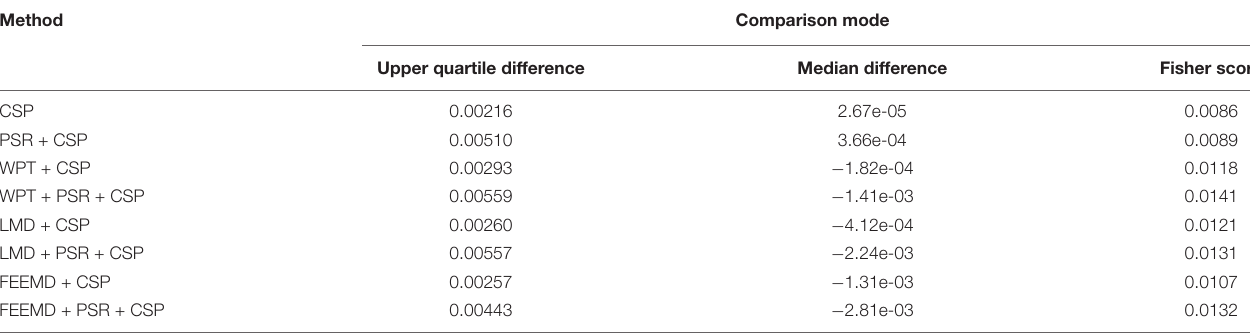
TABLE 4 | BPA values of test samples under the framework (cid:50) . S i and S i * represent the BPA of test samples 1 and 2, respectively. s f and s f * represent the BPA of test samples 1 and 2, respectively, according to D–S decision fusion rules.